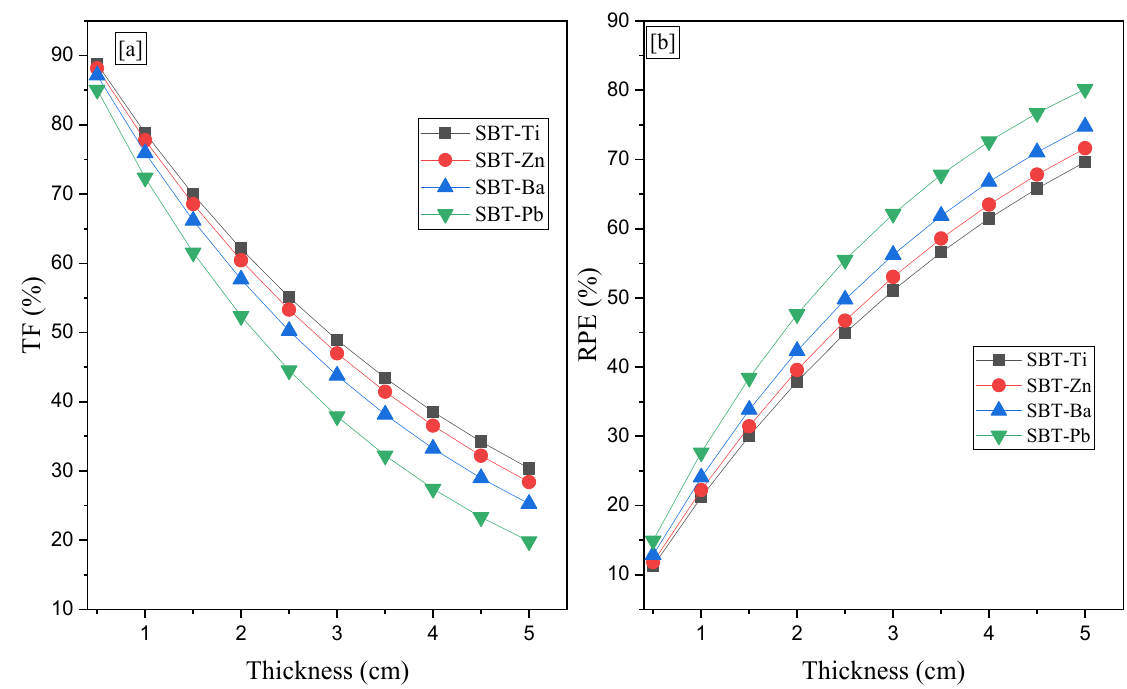
Figure 10. ( a ) Variation of the transmission factor (TF) and ( b ) the radiation protection efficiency (RPE) versus the SBT glasses thickness.